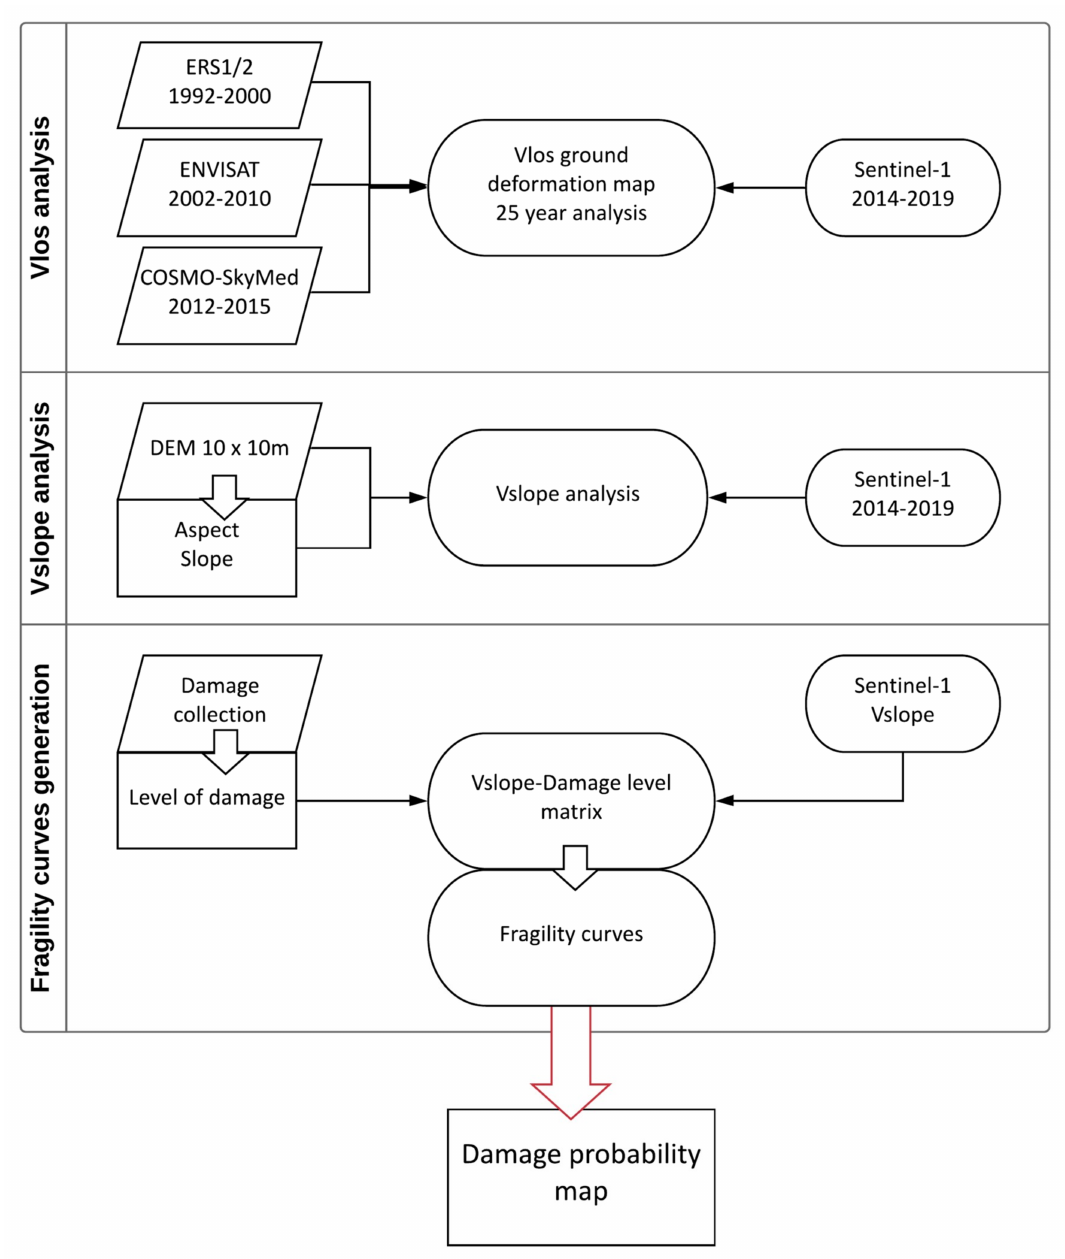
Figure 4. Block diagram of the methodology. Vlos, velocity along the satellite Line of Sight; Vslope, velocity projected along the maximum